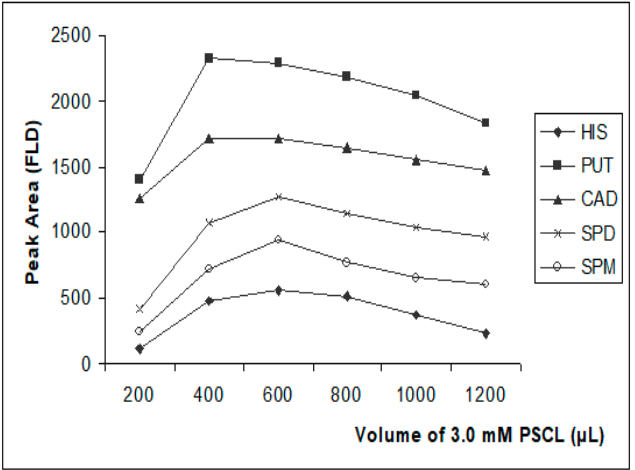
Figure 9. Effect of the volume of the 3.0 mM PSCl solution on the efficiency of the derivatization reaction with putrescine (PUT), cadaverine (CAD), histamine (HIS), spermidine (SPD) and spermine (SPM) in standard solution of 1 μ g mL − 1 .